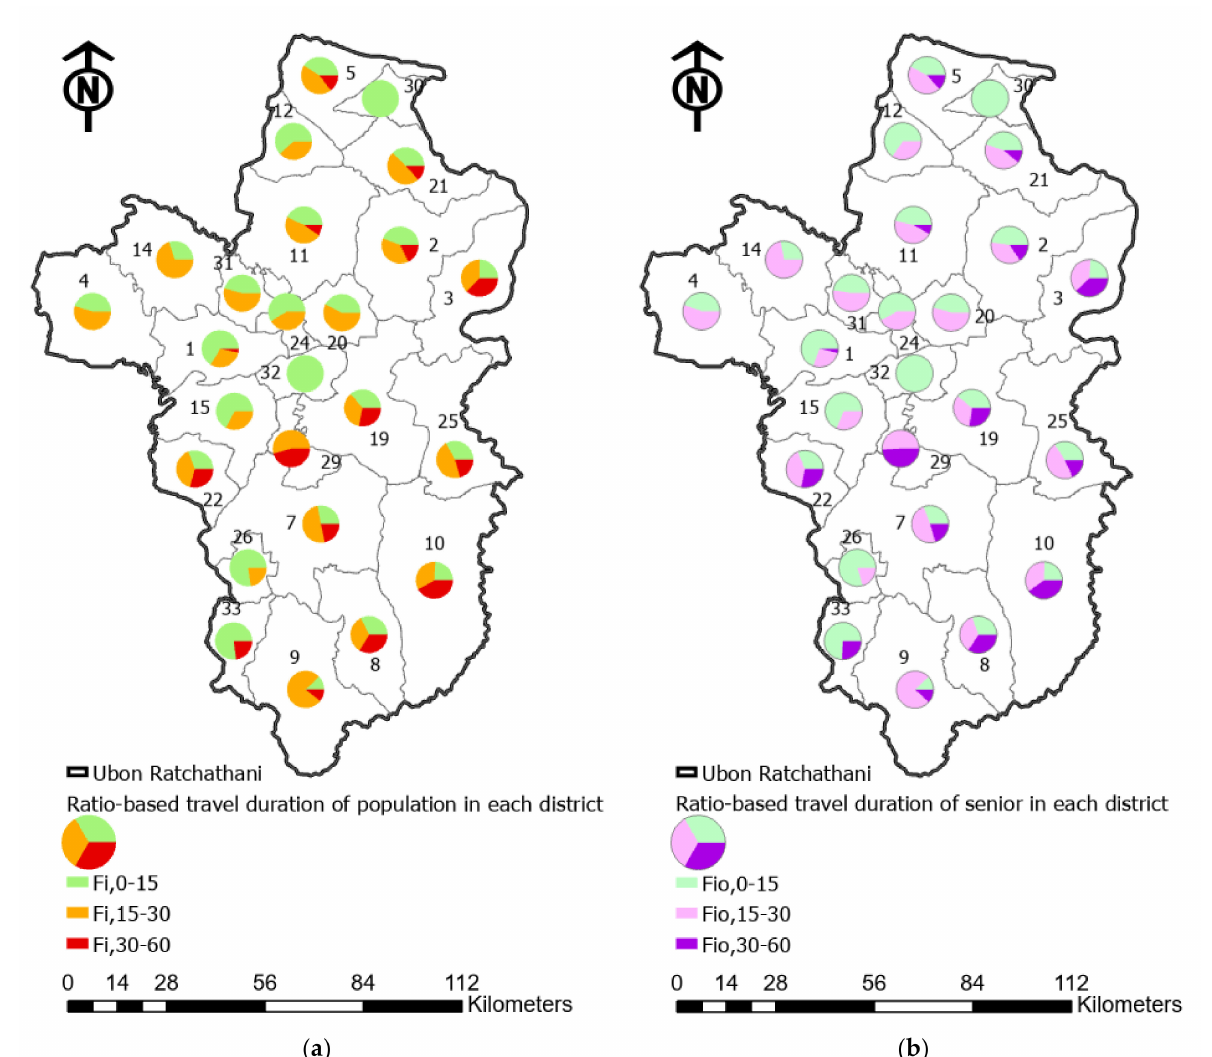
Figure 7. Accessibility levels of each district in Ubon Ratchathani by ( a ) the ratio of the estimated population and ( b ) the ratio of the estimated senior